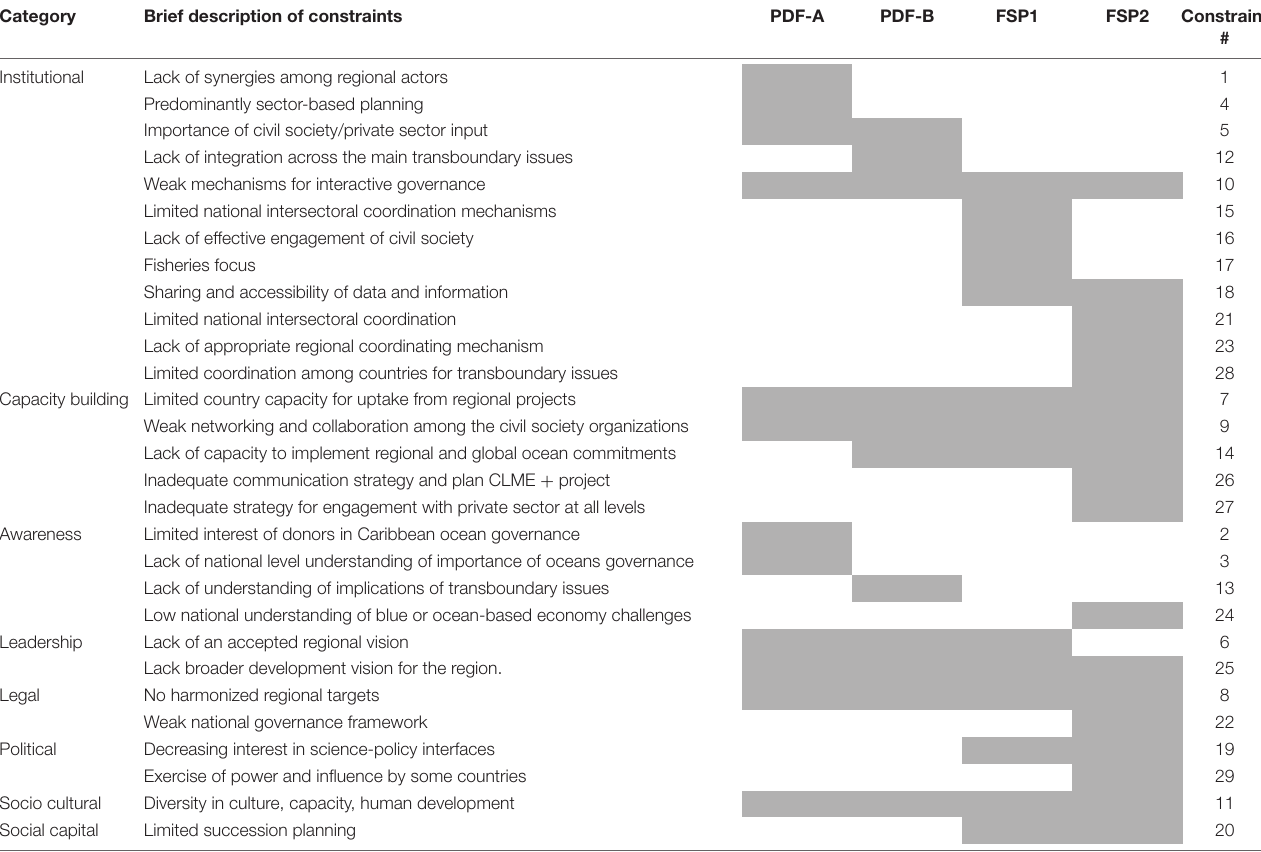
TABLE 4 | Distribution of constraints among the four phases of the CLME initiative by category and phase of the CLME initiative. Category Brief description of